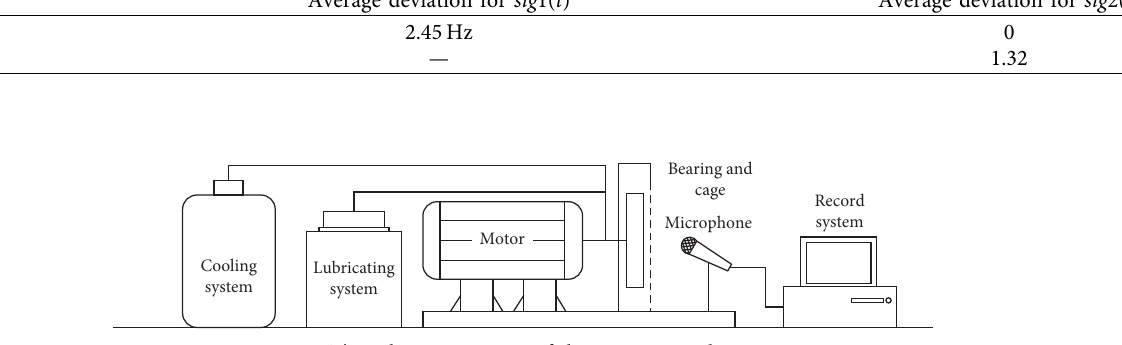
Figure 10: The schematic Figure of the experimental